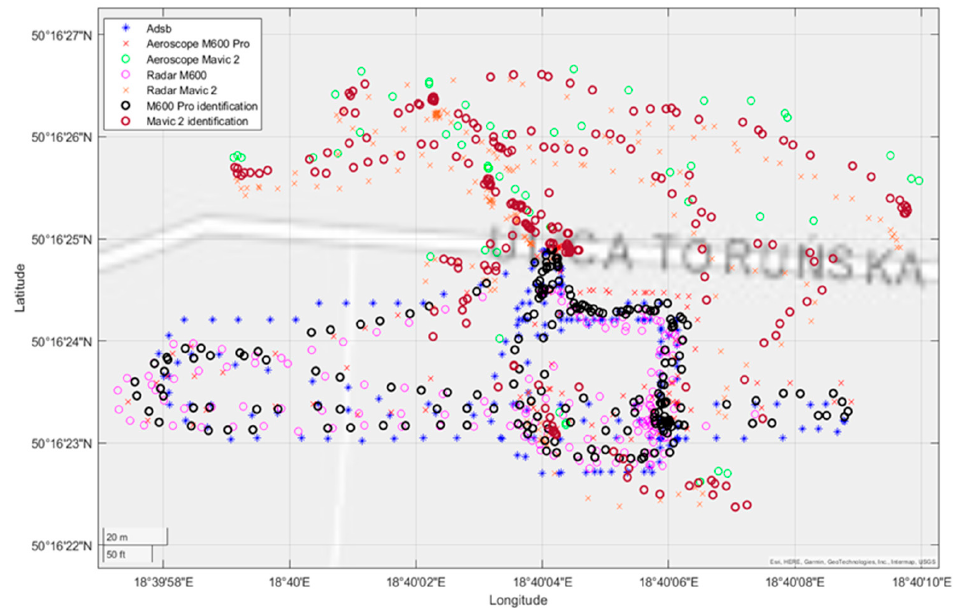
Figure 13. Flight trajectory in 2D space—indirect detections and identifications.